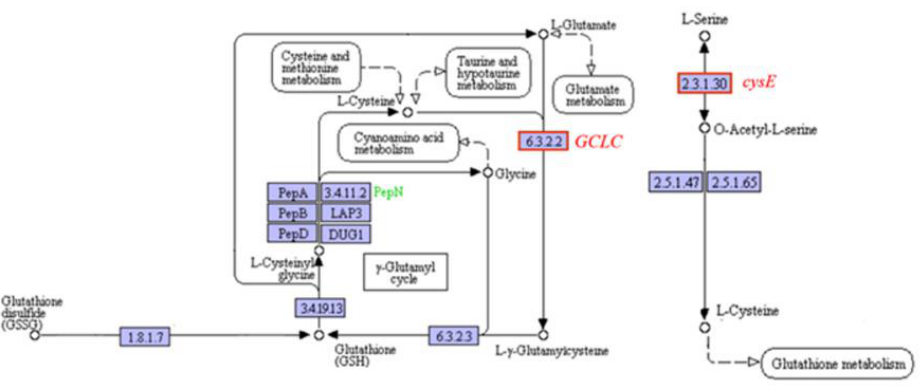
Figure 10. Gene expression of glutamate cysteine ligase gene ( GCLC ) in the red stage and serine O-acetyltransferase gene ( cysE ) in the green stage.